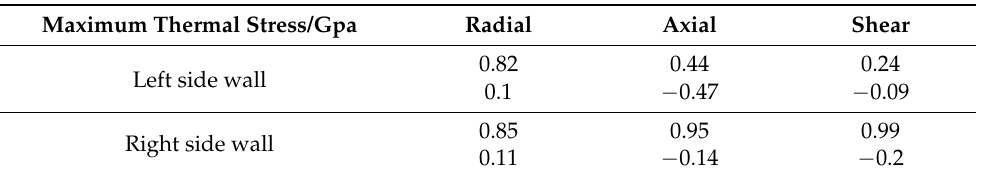
Figure 10. Shear thermal stress cloud diagram at the top and bottom of M2S2 cracks “maintained at 1200 °C.”.